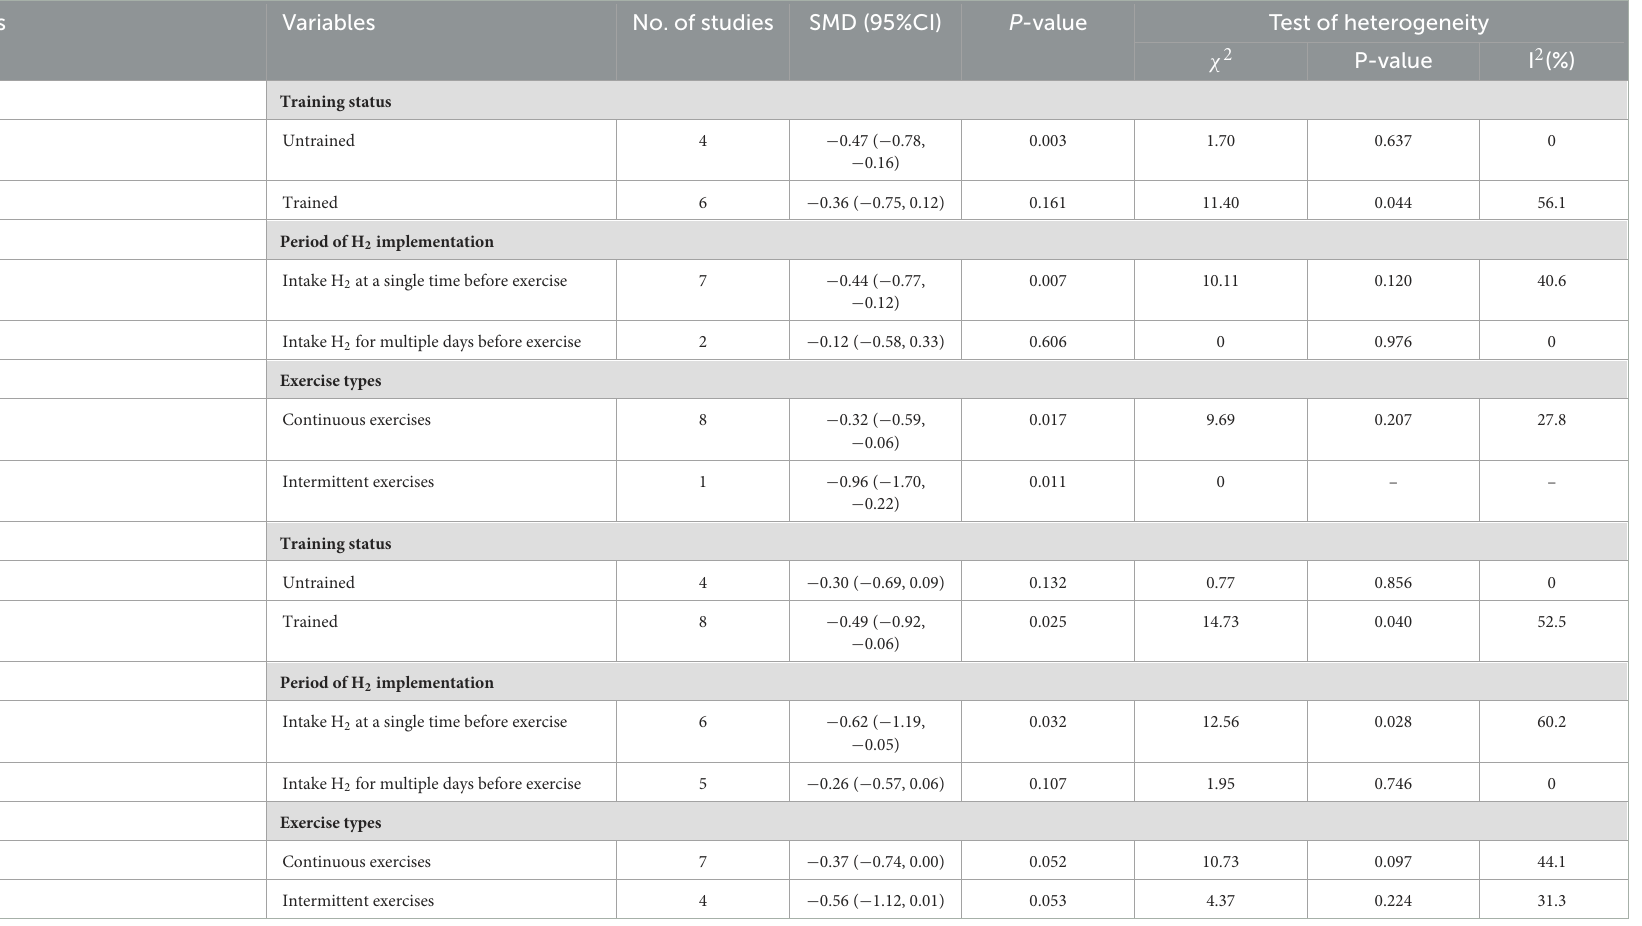
TABLE 2 Subgroup analysis results regarding the effects of H 2 on